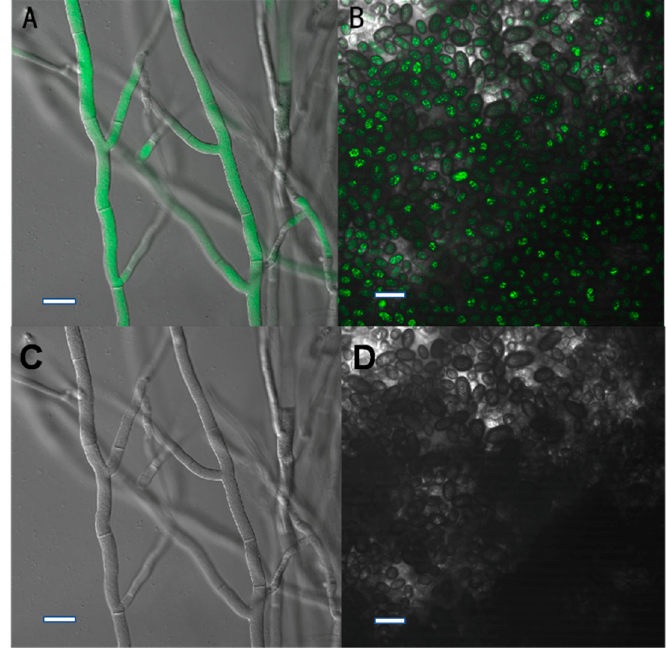
Figure 4. Expression of GFP in the transformants. A , B , green fluorescence was observed in the mycelia and conidia of transformant X1 using a confocal microscope; C , D , the mycelia and conidia in visible light. Bars: A – D = 10 μ m.